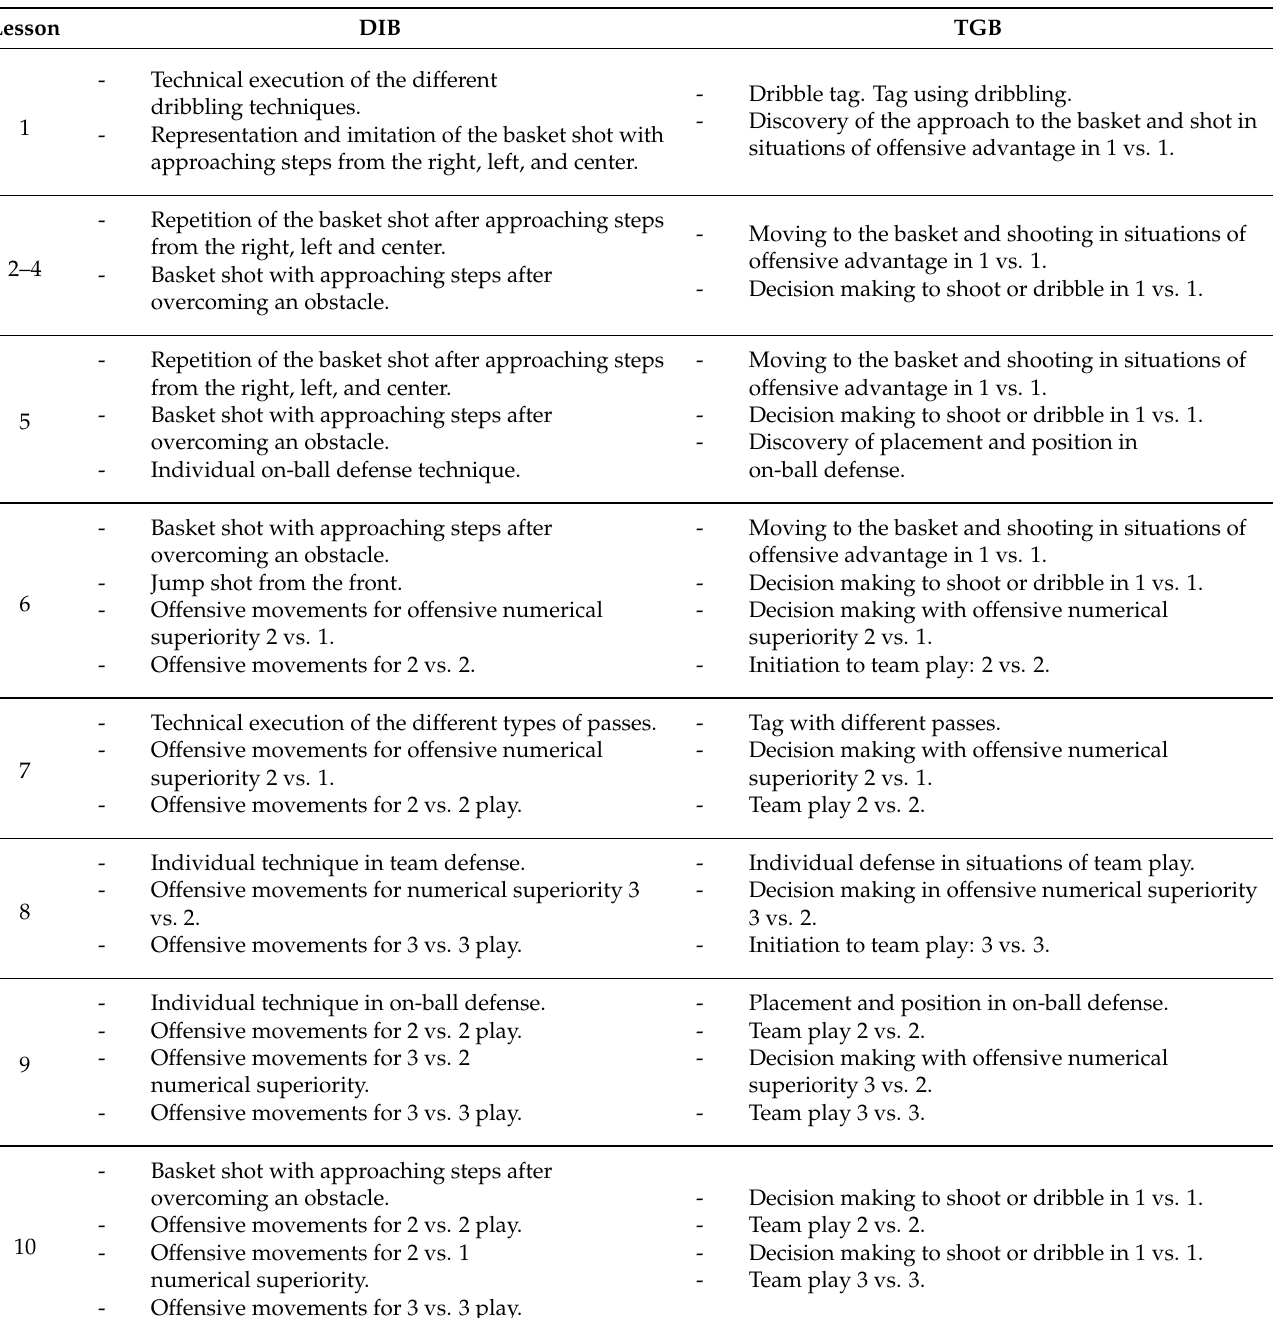
Table 1. Unit plans for the two instructional